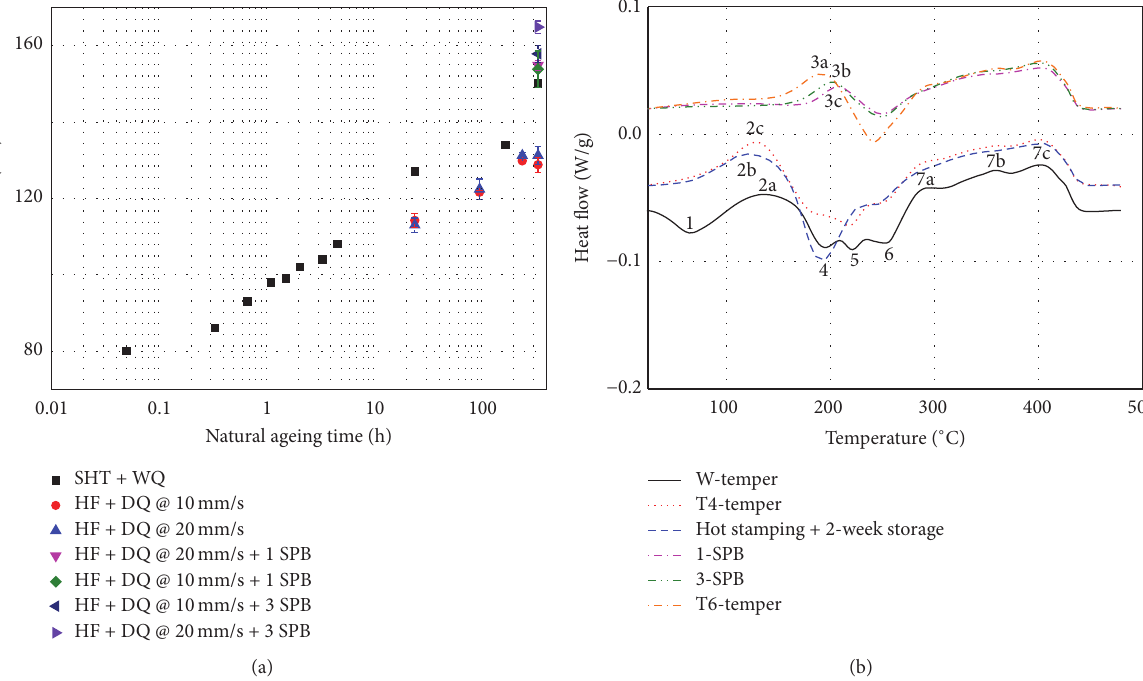
Figure 6: (a) Hardness of the side-wall “smiley” prototype samples following 2 weeks of storage, as well as after subsequent 1-step and 3-step paint baking. HF + DQ refers to hot forming and subsequent die quenching. (b) DSC curves of AA7921 in W-temper, T4-temper, and hot stamping followed by 2 weeks of natural ageing and after two different subsequent paint baking procedures (1-step and 3-step paint baking (1- and 3-SPB)). These DSC curves compared with the DSC curve of AA7921 in the T6